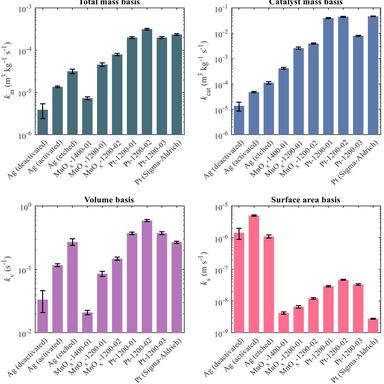
Room temperature rate constants for the tested catalysts. Clockwise from top left: per unit mass basis, per unit mass of catalyst basis, per unit volume basis, per unit BET surface area basis.